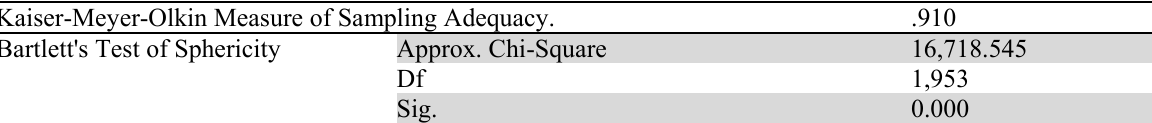
KMO and Bartlett’s Test Kaiser-Meyer-Olkin Measure of Sampling Adequacy. .910